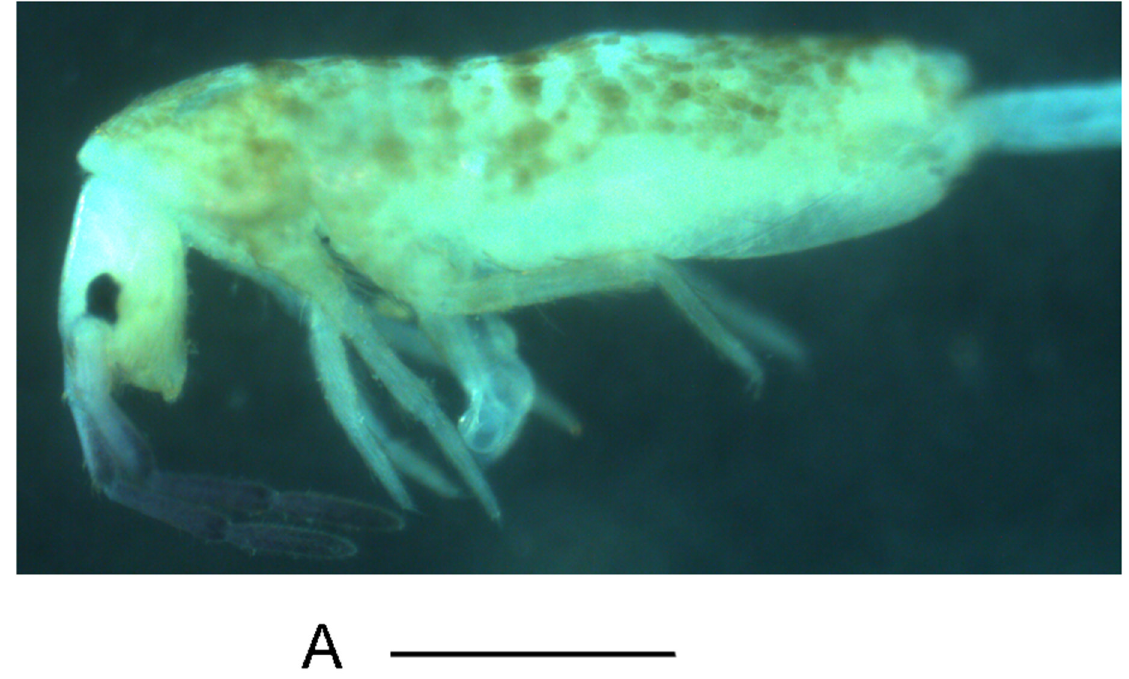
Fig. 10. Lepidocyrtus ( S. ) wanningensis sp. nov. Habitus. Scale bar: 500